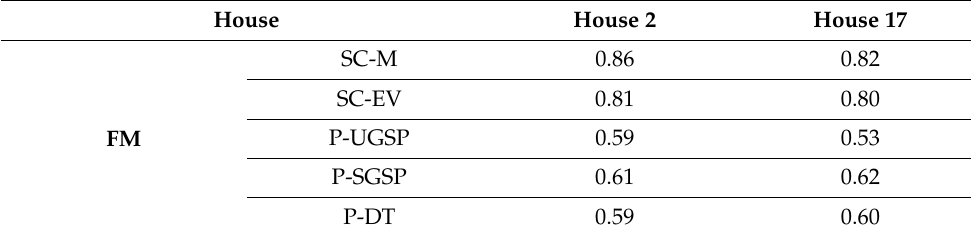
Table 7. Comparison of mean f-measure between proposed and state-of-the-art for refit data. House